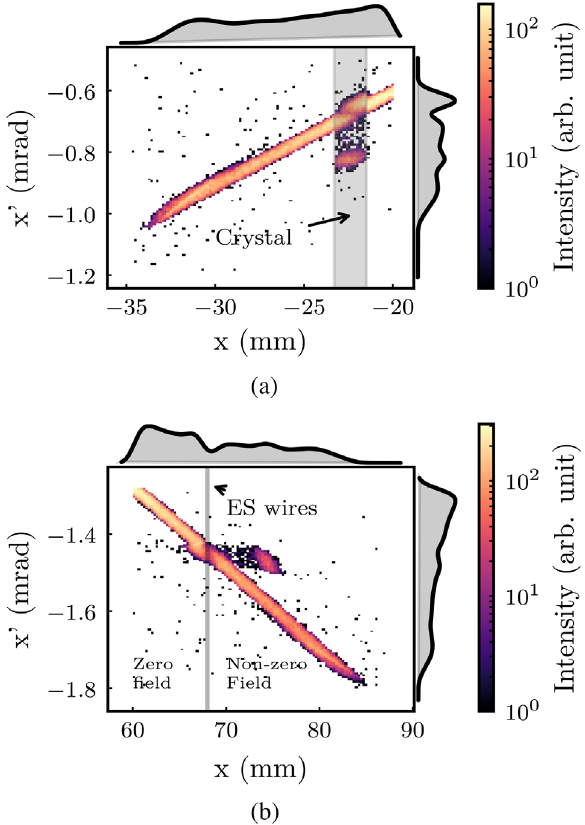
FIG. 12. Shadowing of ES with thin crystal. The phase space distribution at the crystal of width 1.8 mm (shaded) with the coherently channeled particles is plotted, together with the phase space distribution at extraction septum with particles missing the thin wire-array (shaded) on the high-field side and transported into the extraction line. (a) Crystal. (b) Electrostatic septum.